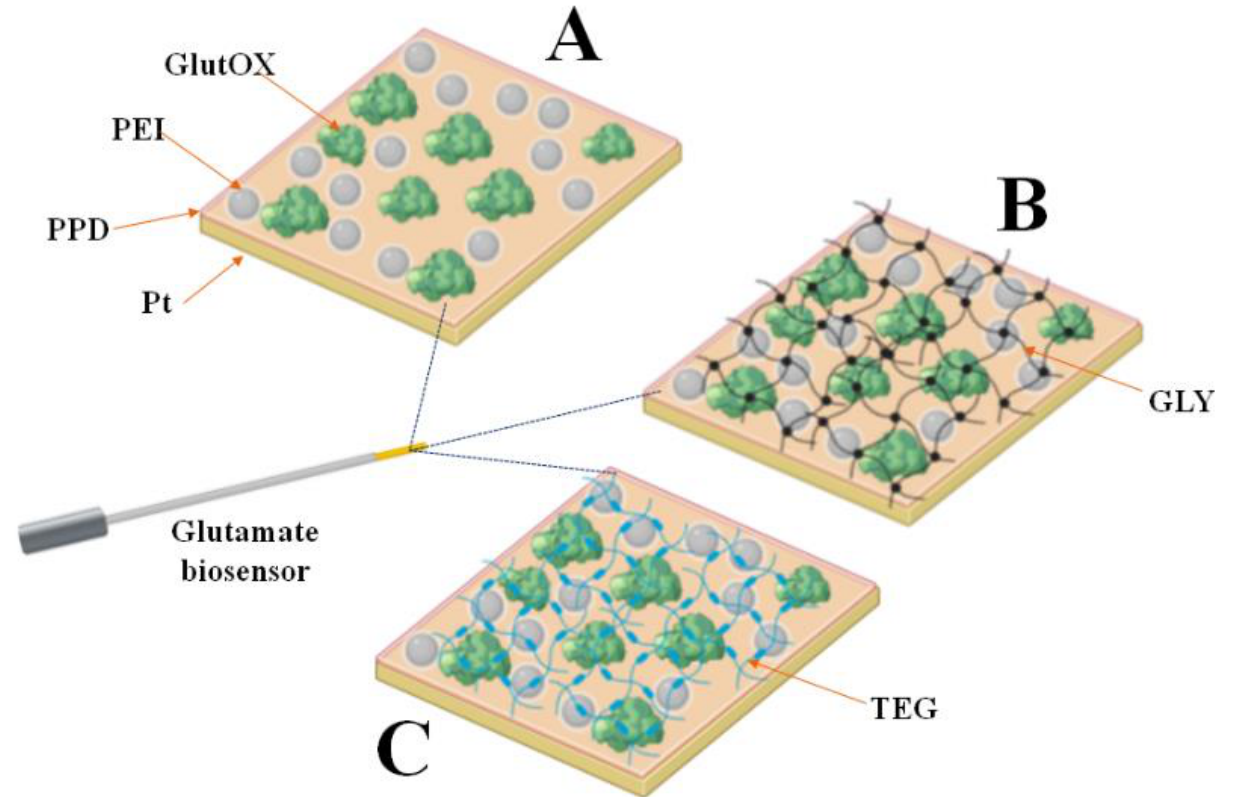
Figure 1. Schematic representation of the glutamate biosensor design characterized in the present study. (Panel ( A )): Pt c /PPD/PEI(1%) 2 /GlutOx 5 (control); (Panel ( B )): Pt c /PPD/PEI(1%) 2 /GlutOx 5 /GLY(0.1%); (Panel ( C )): Pt c /PPD/PEI(1%) 2 /GlutOx 5 /TEG(0.1%). The subscript number represents the number of dips, with the concentration of the glycol in brackets. Pt c : Pt cylinder 1 mm long; GlutOx: L-glutamate oxidase; PPD: ortho-phenylenediamine polymer; PEI: polyethyleneimine; GLY: glycerol; TEG: triethylen glycol.